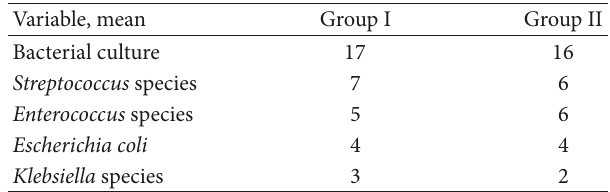
Table 2: Positive results of bacterial culture among treatment